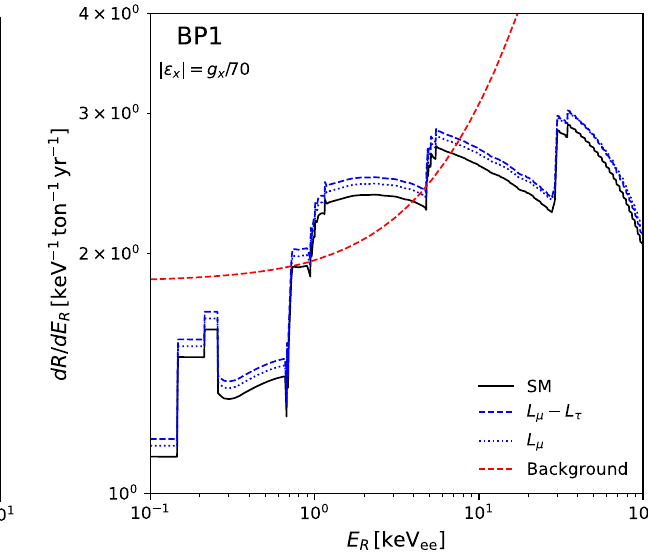
Fig. 10 (Left) Nuclear-recoil spectrum for CE ν NS for a generic Xe detector. The SM prediction is shown in black, while the BSM predic- tion for BP1 is shown in blue for U ( 1 ) L μ − L τ (dashed) and U ( 1 ) L μ (dot- ted).(Right)ElectronrecoilspectrumforagenericXedetector.Arough